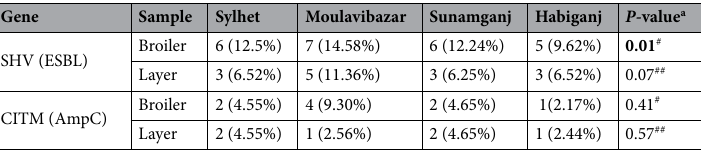
Table 9. Prevalence and distribution of beta-lactam (ESBL and AmpC) antibiotic-resistant genes among the investigated E. coli ( n = 381) isolates in relation to the four districts of Sylhet division under study. a P values calculated using a two-way analysis of variance (ANOVA) without replication. P values < 0.05 are highlighted in bold. # Variance between broiler and layer. ## Variance among the four districts under